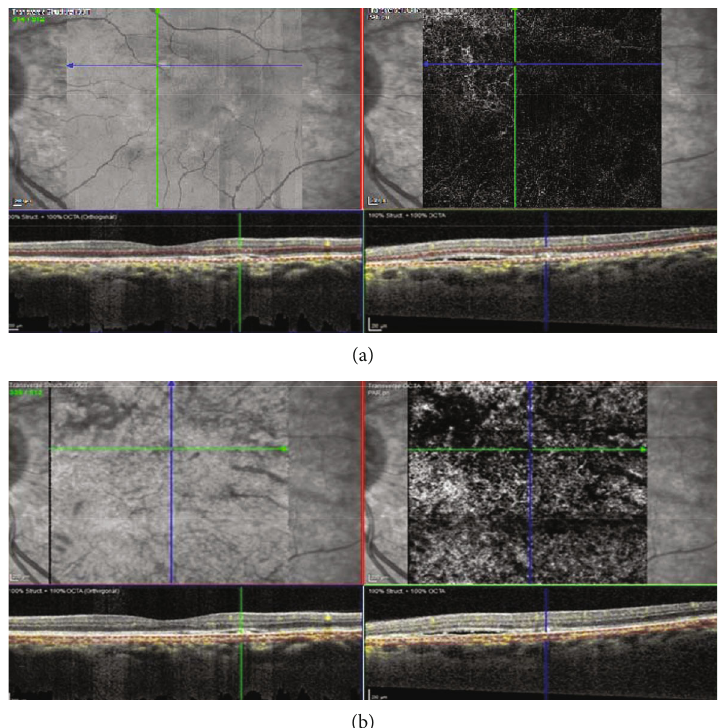
Figure 6: Optical coherence tomography angiography (OCTA) images of left eye corresponding to hyperre fl ective spot on infrared re fl ectance (IR) image showing an abnormal network in avascular layer and presence of prominent underlying and adjoining large dilated choroidal vascular complex.